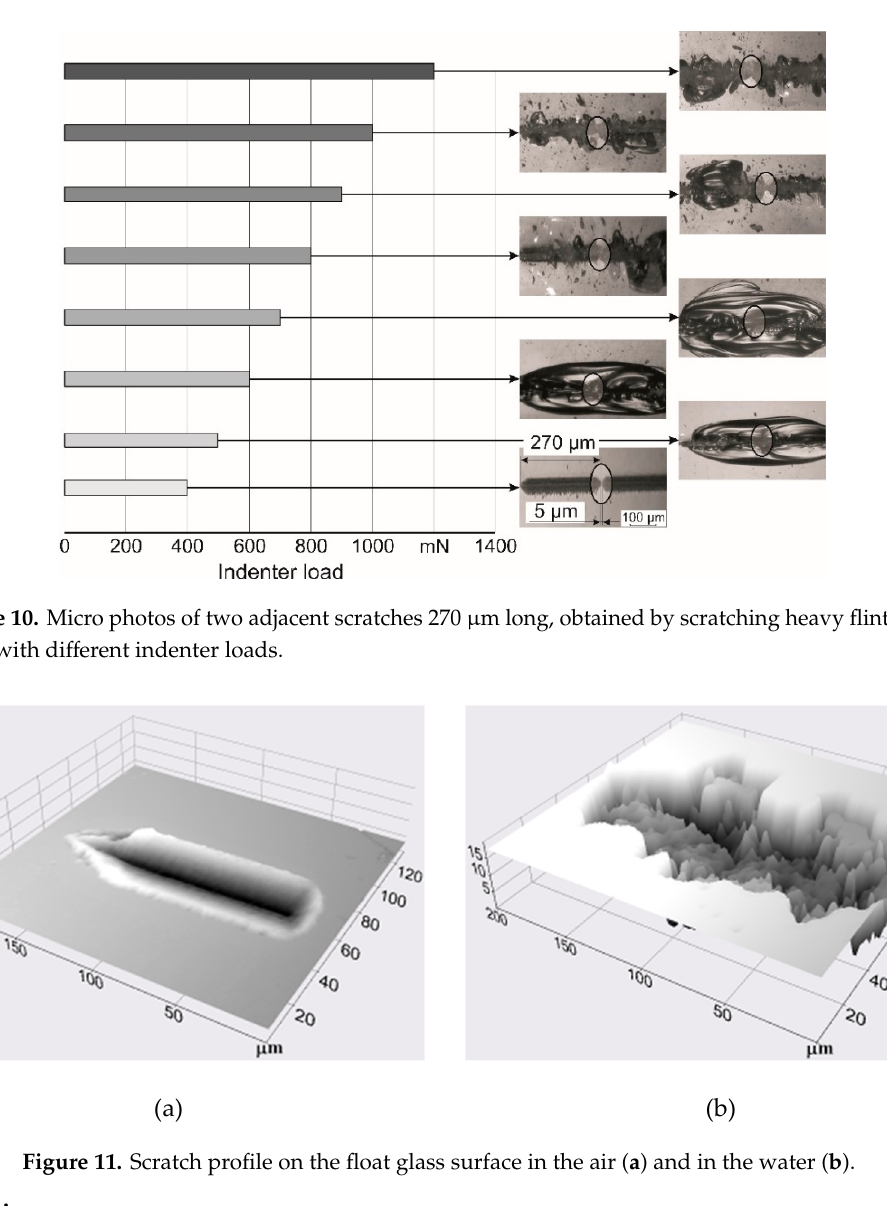
Figure 9. Lateral cracks by discrete scratching of glasses.